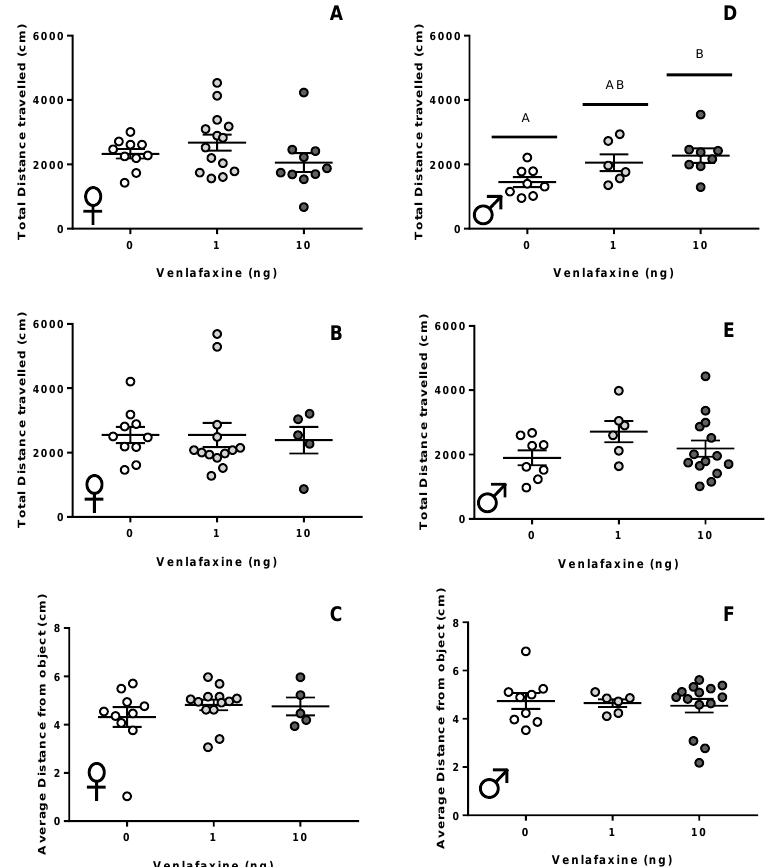
Figure 4. Behavioural assessment of adult fish. Total distance travelled by adult female ( A – C ) or male ( D – F ) zebrafish observed in a lateral view ( A , D ), open field ( B , E ), or novel object assessments ( C , F ). Zebrafish were originally exposed to either 0, 1, or 10 ng venlafaxine at the 1–4 cell stage. Zebrafish were recorded for 5 min immediately after placement into the arena. Total movement and the total distance away from the novel object are shown. Individual data points are shown with a mean ± SEM, with different letters used to denote significant differences between means.